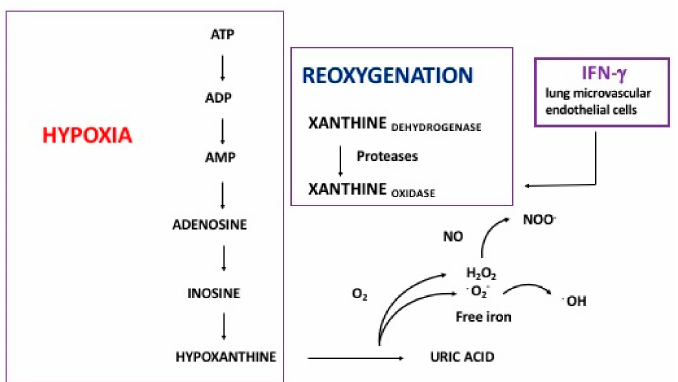
Figure 3. Schematic representation of free radical generation during hypoxia–reoxygenation. Hy- poxanthine derives from degradation of adenosine 5 (cid:48) -triphosphate (ATP) during hypoxia-induced anaerobic metabolism. During reoxygenation, xanthine oxidoreductase catalyzes hydroxylation of hypoxanthine to xanthine and uric acid, inducing the release of ROS. Xanthine oxidoreductase exists in two forms: xanthine dehydrogenase and xanthine oxidase. An irreversible proteolytic conversion of xanthine dehydrogenase to xanthine oxidase can also be specifically induced by IFN- γ in lung microvascular endothelial